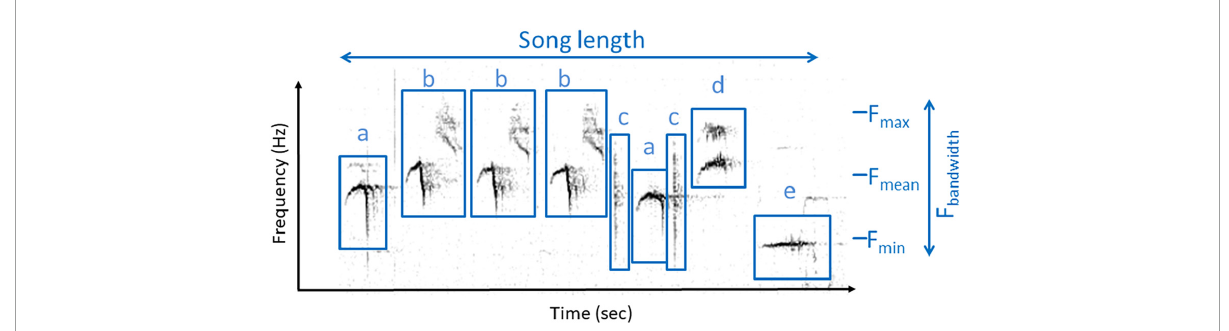
FIGURE1 Spectrogram of a collared flycatcher song depicting the song traits used in the analyses. Tempo was calculated by dividing the number of syllables in the song by song length, and complexity was calculated by dividing the number of syllable types (indicated by different letters) by the total number of syllables in the song. F max , F mean , F min , maximum, mean, minimum frequency; F bandwidth , frequency bandwidth.